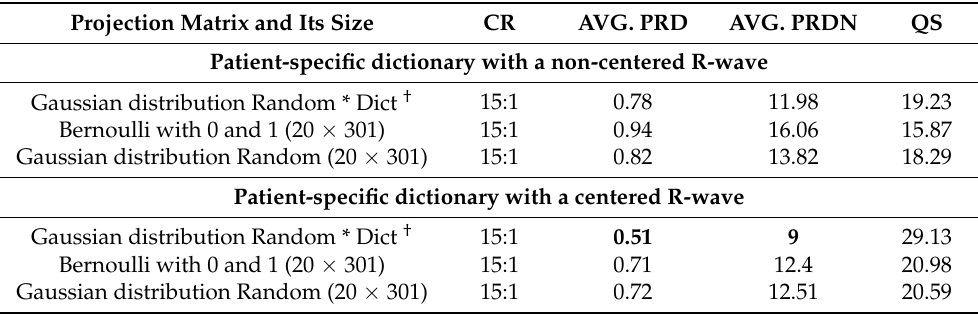
Table 8. Average results for 24 ECG Records for the CSCP method with a patient-specific dictionary built from the first 700 cardiac cycles.